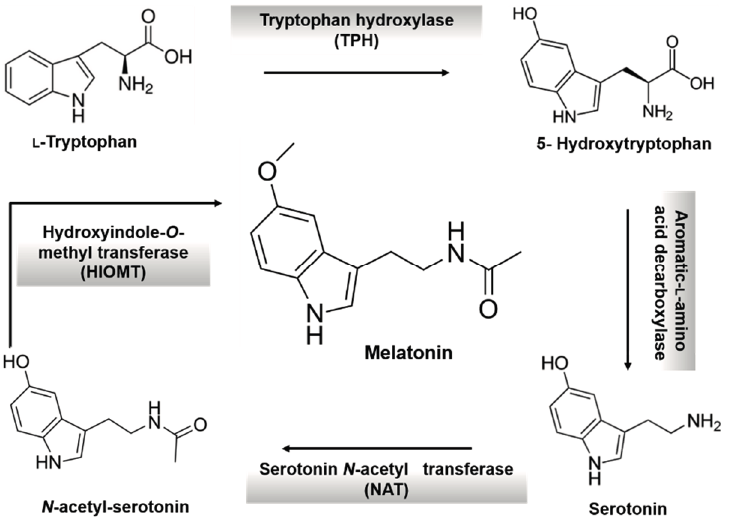
Figure 1. Biosynthesis of melatonin from